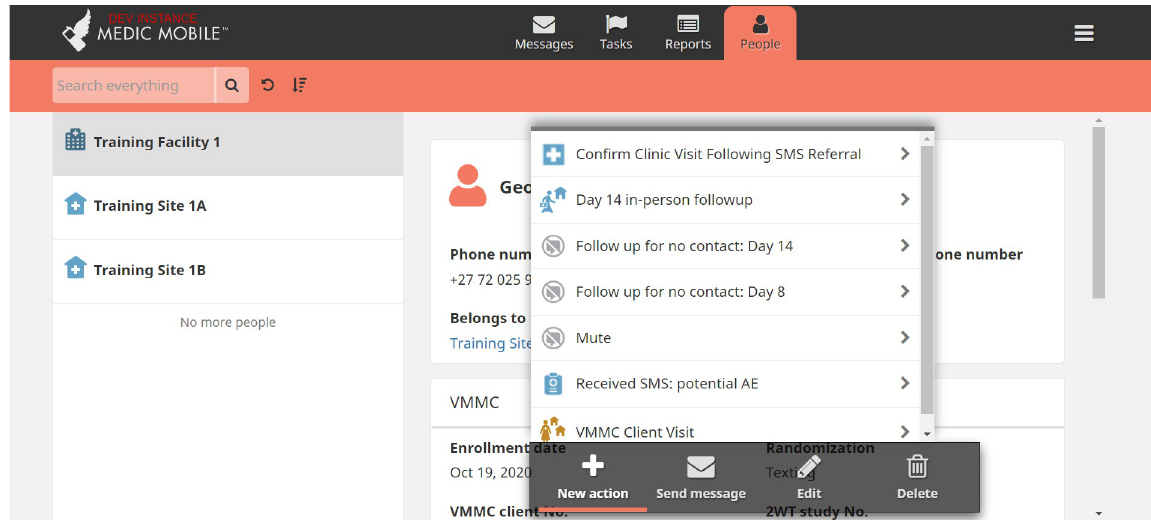
Fig 1. CHT “Person Tab”. This 2wT tab displays options for nurses to complete various 2wT Reports and Tasks for any enrolled patient on the PC or mobile (tablet or phone) app.